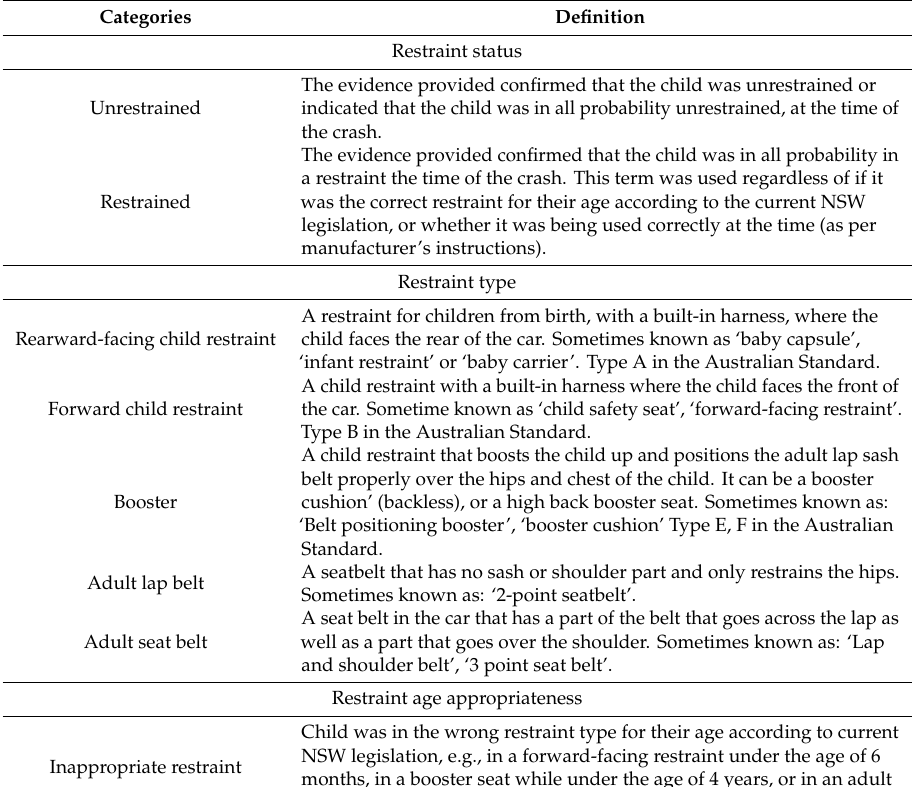
Table 1. Categories and definitions for restraint factors at the time of the crash and the primary contributor to death, reproduced from